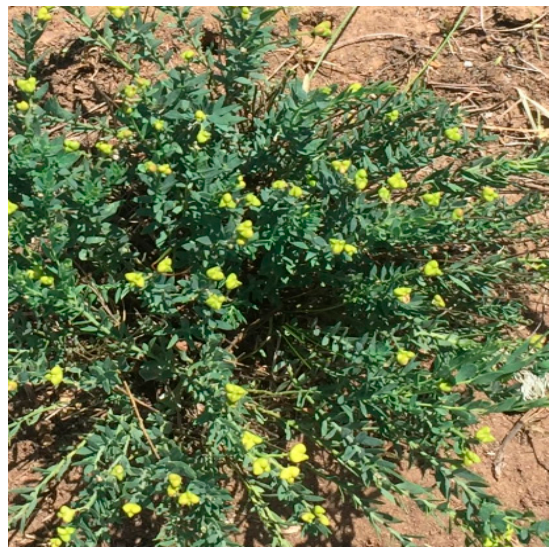
Figure 7. Photo of Haplophyllum dauricum from Baiyinkulun Grassland. Potentilla chinensis